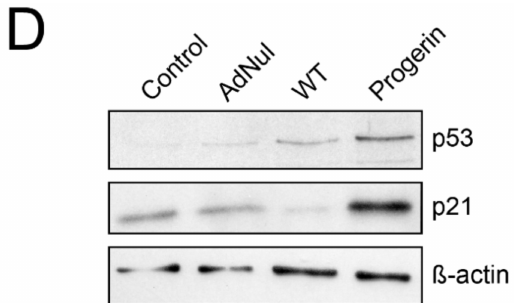
Figure 3. Endothelial progerin expression induces oxidative stress, DNA damage and cellular senescence. Early-confluent HCAECs were transduced or not with Flag-tagged recombinant adenovirus containing WT-prelamin A or progerin or with an empty vector. ( A ) Reactive oxygen species (ROS) production was assessed by the oxidation of 5-6-chloromethyl-2,7-dichlorodihydro-fluorescein diacetate (CM-H2DCFDA). ( B ) Relative mRNA expression of DDIT3 . ( C ) DNA double-strand breaks (DSBs) were studied by staining HCAECs with Ser139-phosphorylated histone variant H2A ( γ -H2AX, in green) and di-amidino-2-phenylindole hydrochloride (DAPI) (in blue) (upper panel) and evaluated as the percentage of γ -H2AX–positive cells (40–200 cells per experiment) (lower panel). ( D ) Protein expression of the cell cycle arrest proteins p53 and p21. Representative picture of n = 3 experiments. ( E ) Senescence-associated (SA)- β -galactosidase activity was assessed by the percentage of 5-bromo-4-chloro-3-indolyl- β -d-galactopyranoside (X-gal)-stained HCAECs (in blue) at pH6. Representative micrographs are shown (upper panel). Data are expressed as the mean ± SEM and statistical di ff erence determined using ANOVA followed by a Dunnett post hoc test. ** p < 0.01, *** p < 0.001 vs.